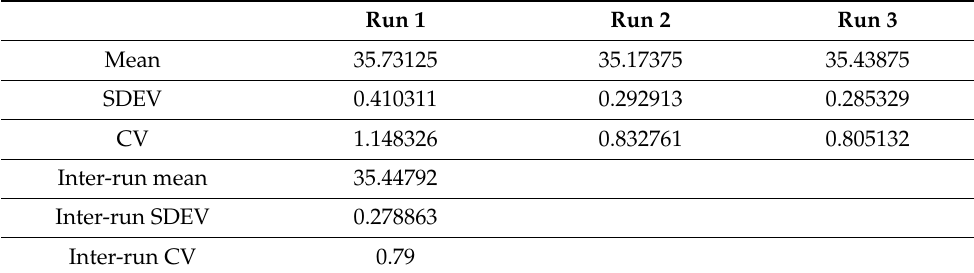
Table 4. Repeatability of the KV-2 assay.